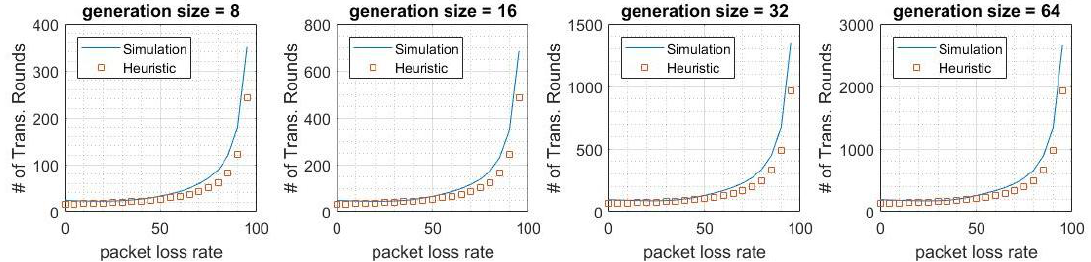
Figure 4. Average number of transmissions in all links in unrestricted coding.